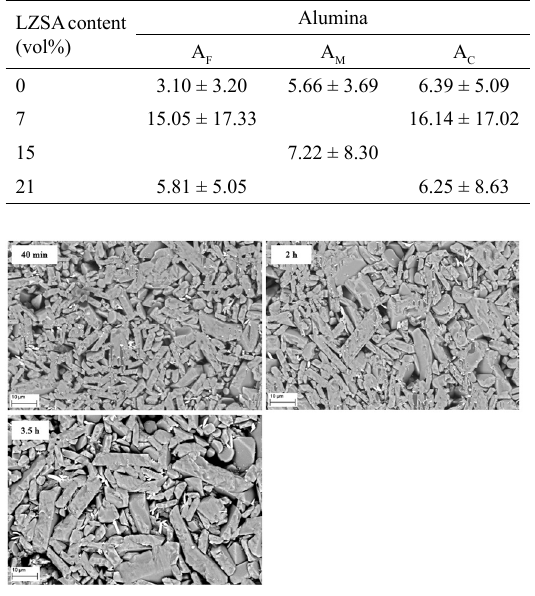
21 sintered at 1,600 C = 0.95; 2 h, d = 0.96; rel rel